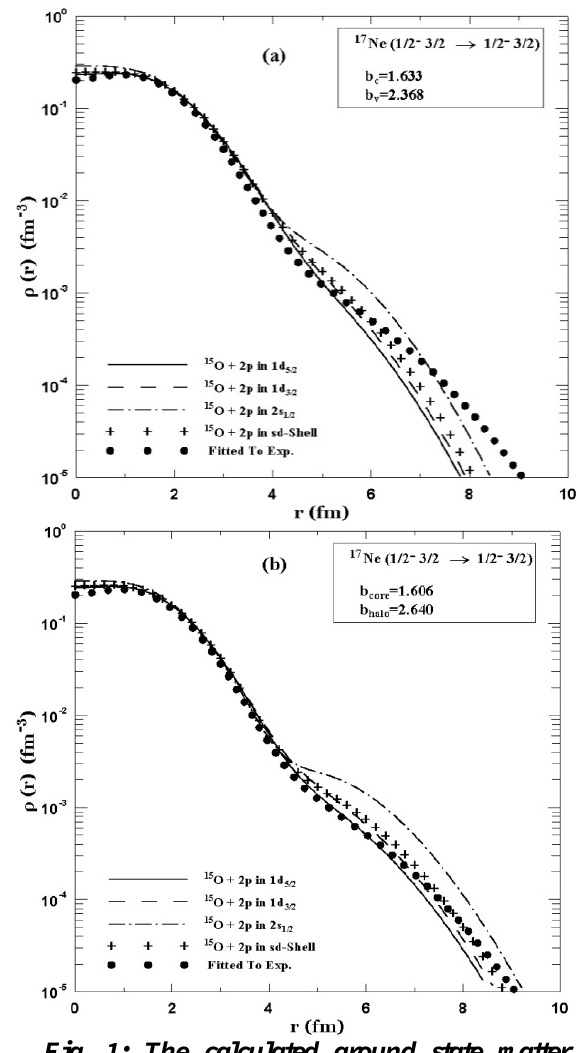
Fig. 1: The calculated ground state matter densities of 17 Ne nucleus . the filled circles are the experimental data extracted from Glauber model